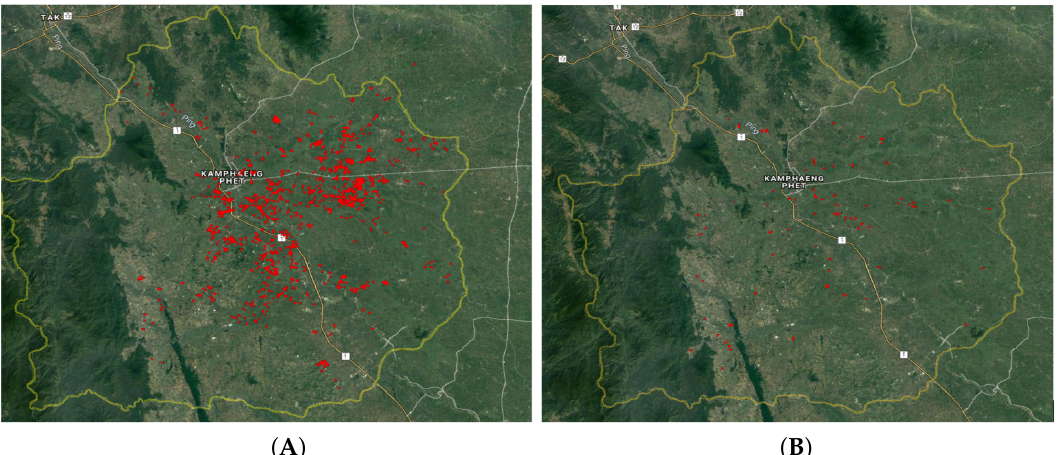
Figure 2. Population and sampling data of sugarcane plantation: ( A ) population and ( B ) sampling.